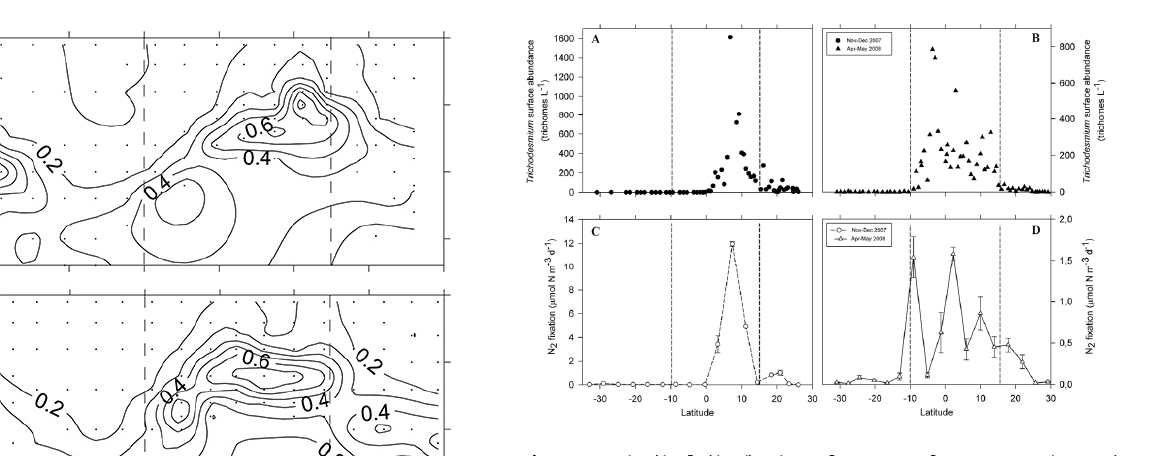
Fig. 7. Latitudinal distribution of mean surface N 2 fixation and surface Trichodesmium spp. abundance during the 2007 (left-hand plots) and 2008 (right-hand plots) cruises. Bars in the N 2 fixation plots represent the standard deviation of the mean ( n = 3).